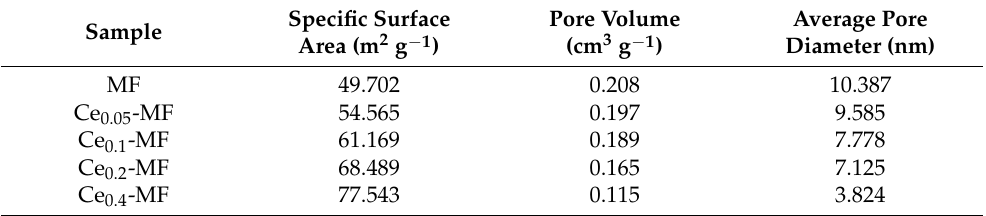
Table 1. Pore structure characteristics of the catalysts with different Ce doping proportions.